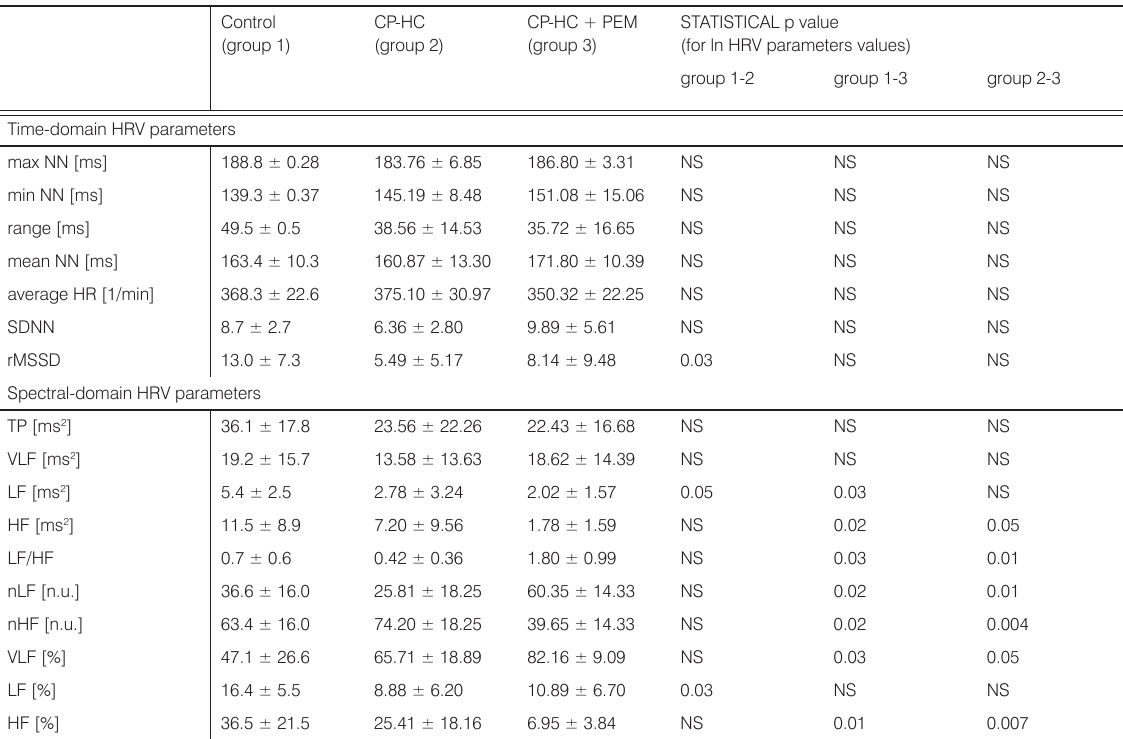
Table 2. HRV analysis in cyclophosphamide-induced haemorrhagic cystitis without and with pemirolast